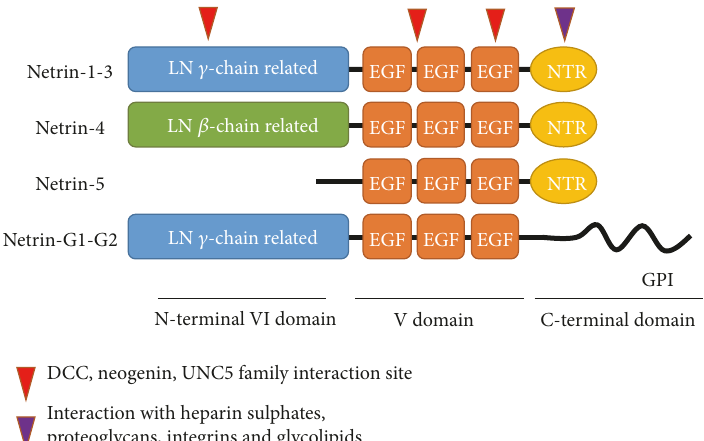
Figure 1: Schematic domain architecture of the netrins depicting a laminin-like (LN) domain, three epidermal growth factors like repeats (EGF), and the C-terminal domain (NTR). Arrow heads indicate interaction sites with the various netrin receptors or extracellular matrix